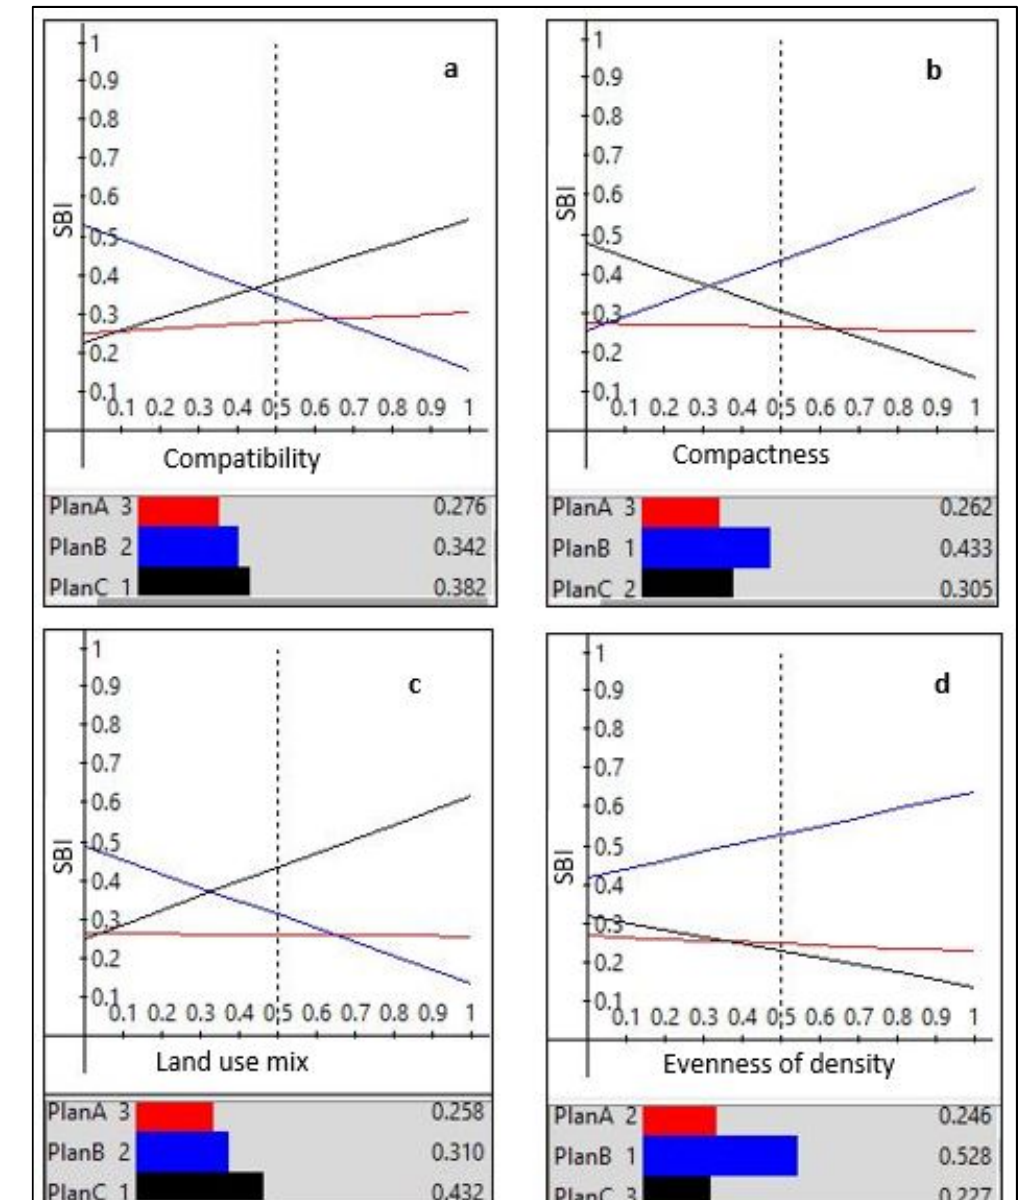
Figure 7. Sensitivity of SBI with respect to ( a ) compatibility, ( b ) compactness, ( c ) land use mix, and ( d ) evenness of population distribution.